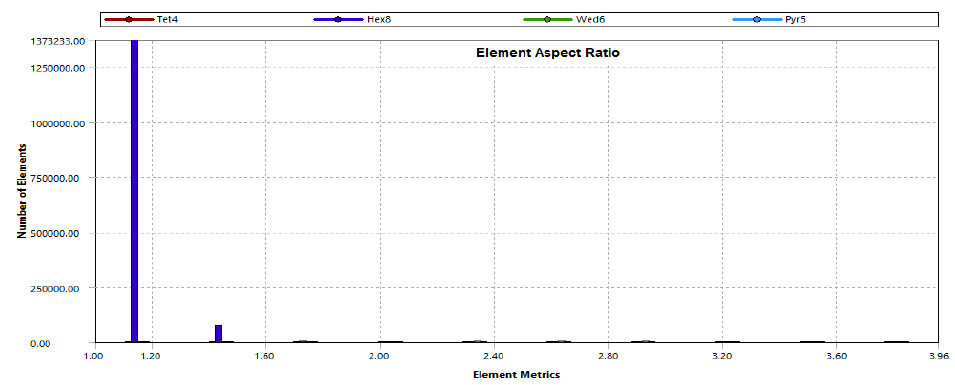
Figure 6. Aspect ratio of the elements.